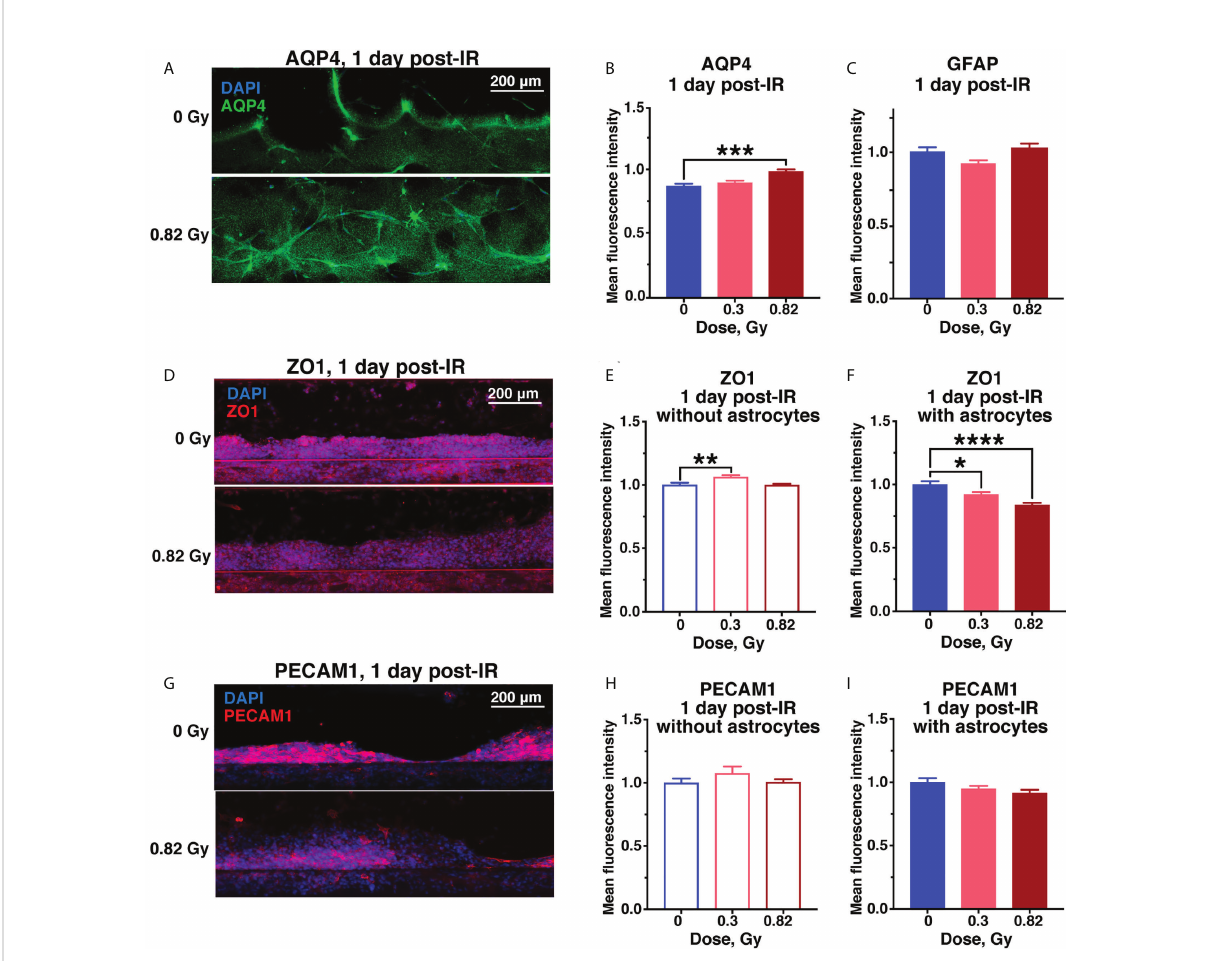
FIGURE 4 Acute astrocyte and endothelial cell damage from 600 MeV/n 56 Fe irradiation. Representative images (A) and quanti fi cation (B) of AQP4 (green) immuno fl uorescence. (C) Quanti fi cation of GFAP immuno fl uorescence in the same chips as (B) . (D – F) . Representative images (D) and quanti fi cation of ZO1 (red) immuno fl uorescence in chips with endothelial cells only (E) and with endothelial cells and astrocytes (F) . (G – I) . Representative images (G) and quanti fi cation of PECAM1 (red) immuno fl uorescence in chips with endothelial cells only (H) and with endothelial cells and astrocytes (I) . All images counterstained with DAPI + nuclei (blue). Open bars, chips with endothelial cells only. Shaded bars, chips with endothelial cells and astrocytes. Blue, 0 Gy sham irradiation. Light red, lower dose (0.3 Gy). Dark red, higher dose (0.82 Gy). N = 12-24 areas from 6-12 chips per condition. Error bars, mean ± SEM. *p < 0.05, **p < 0.01, ***p < 0.001, ****p < 0.0001, 1-way ANOVA, Dunnett ’ s multiple comparisons test. Non statistically signi fi cant changes are not